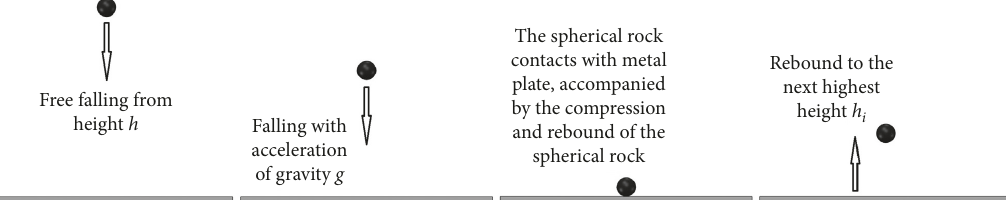
Figure 1: Free-falling impact model.